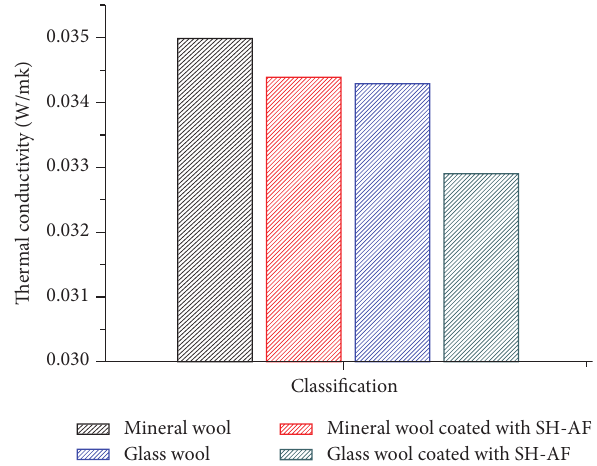
Figure 6: Thermal conductivity of mineral wool and glass wool.